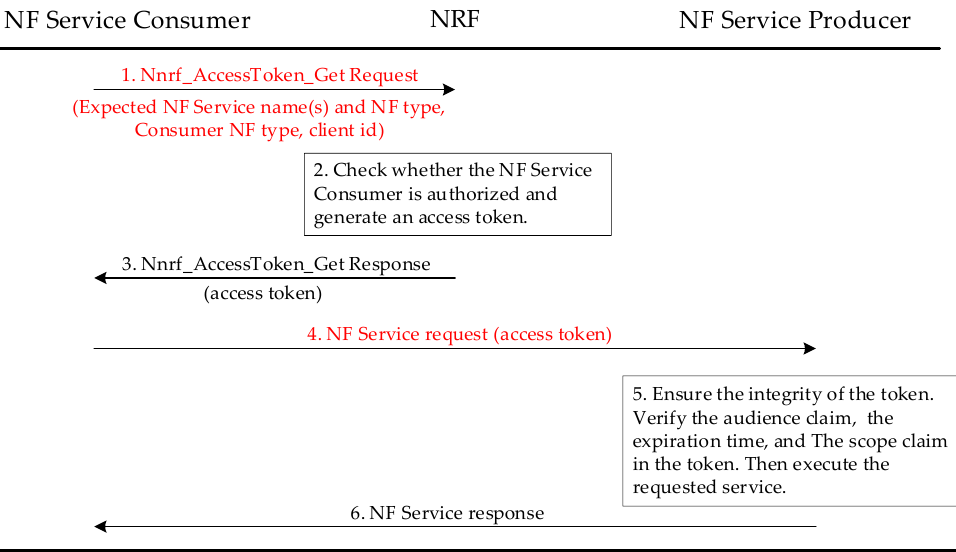
Figure 1. NF service access procedure [19].